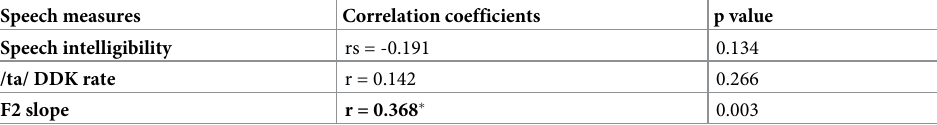
Value in bold and with asterisk indicates that r is significant (p < 0.01) (two-tailed). Correlation analysis used Spearman’s rank correlation coefficient for intelligibility and Pearson’s correlation coefficient for other indicators. /ta/ is a syllable pattern comprising a lingual–alveolar consonant with a vowel. DDK, diadochokinesis; F2, second